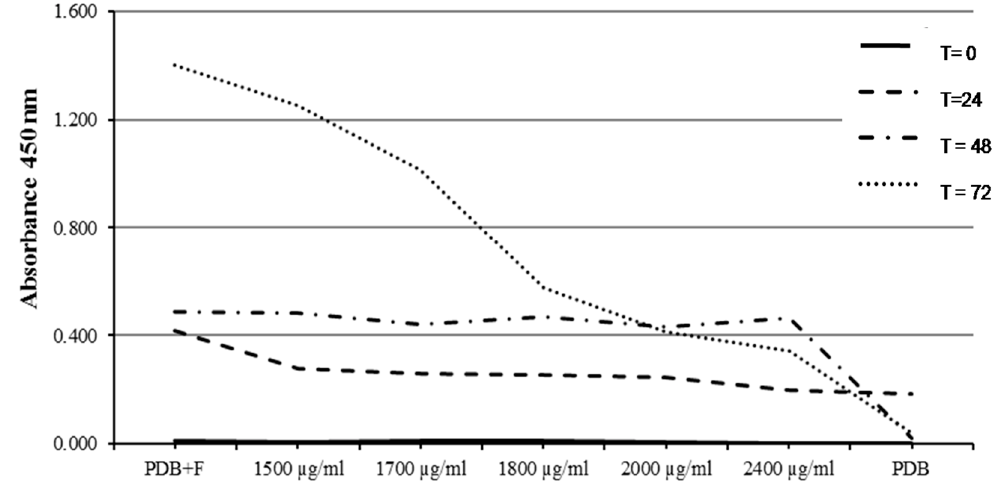
Figure 6. MIC of O. majorana EO against Monilinia fructicola .